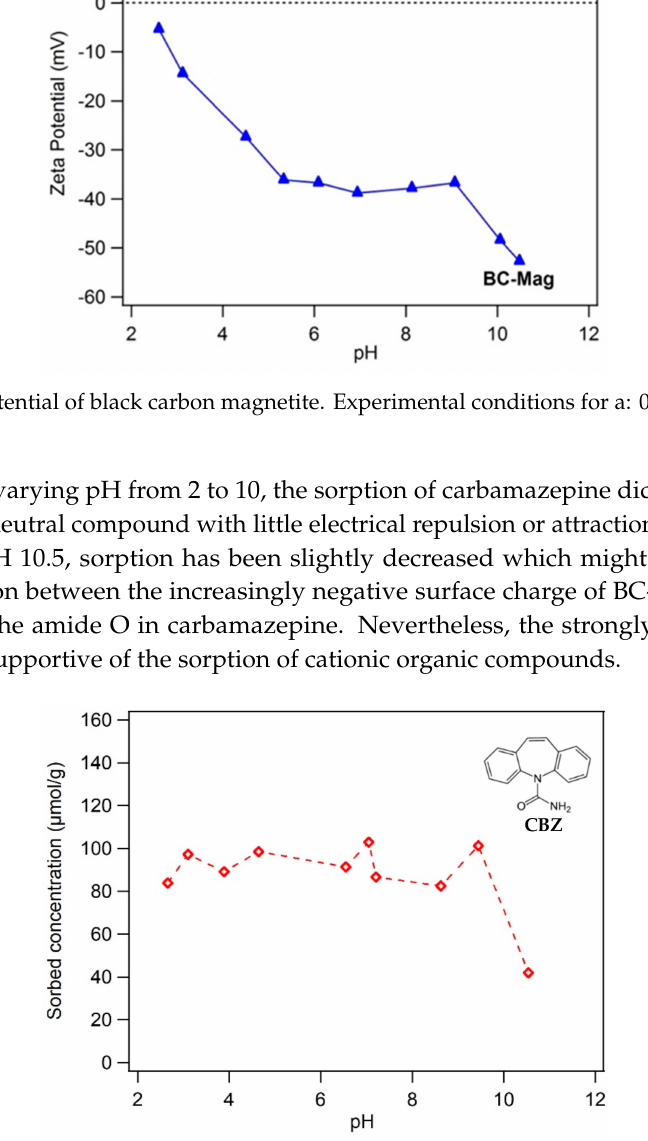
Figure 8. E ff ect of pH on the neutral sorbate carbamazepine. Experimental conditions: 0.5 g L − 1 black carbon magnetite and initial sorbate concentrations of 70–80 mg L − 1 in a bu ff er solution of 1 mM NaHCO 3 and 20 mM